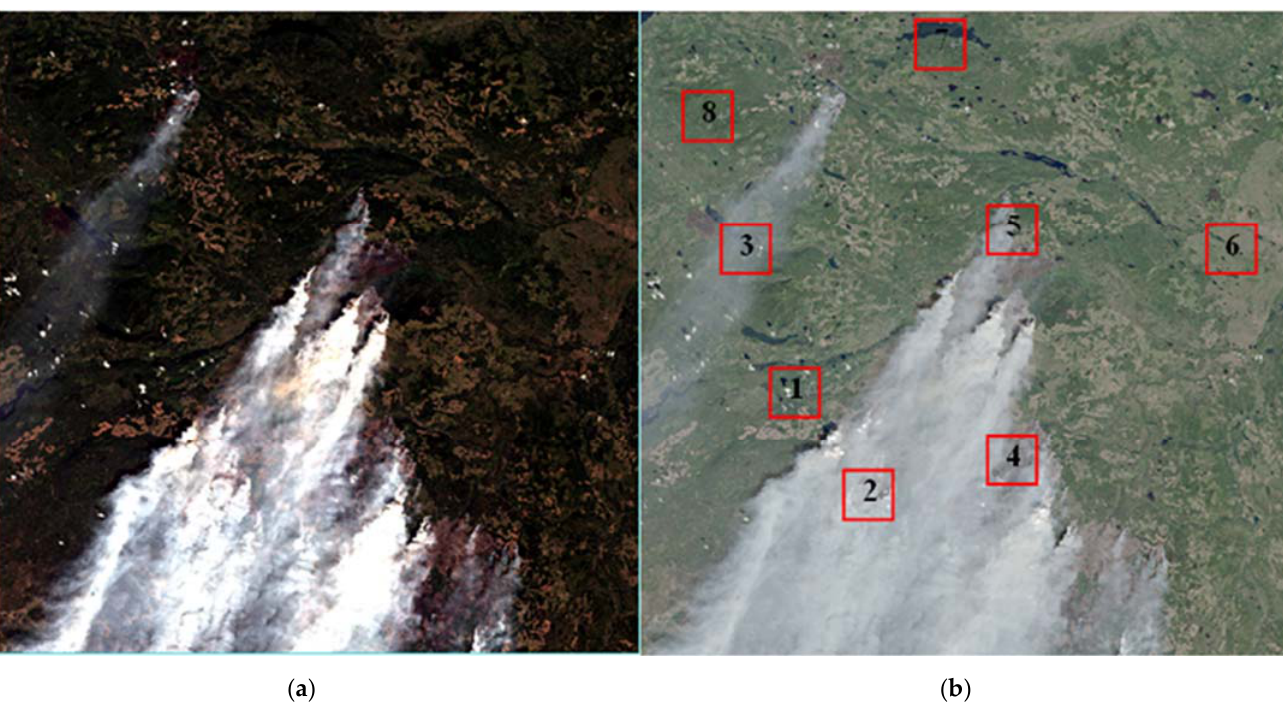
Figure 10. The image of smoke acquired over British Columbia, Canada, on 4 August 2017. ( a ) The true-color composition image. ( b ) The image of smoke after logarithmic transformed. Different targets are marked with numbers 1 through 8. (1) The cloud; (2) The heavy smoke; (3) The thin smoke over area 3; (4) The thin smoke over area 4; (5) The smoke over the hot spot; (6) The soil; (7) The water; (8) The vegetation.